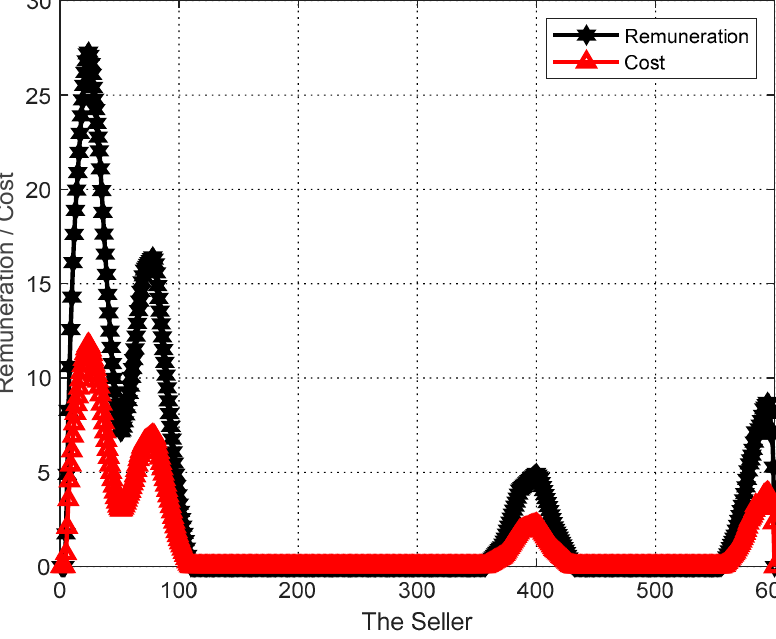
Figure 2. Personal analysis of the user.